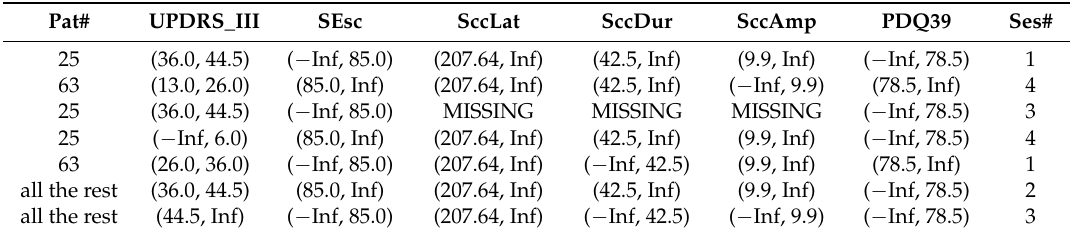
PDQ scale give significant value for prediction results.